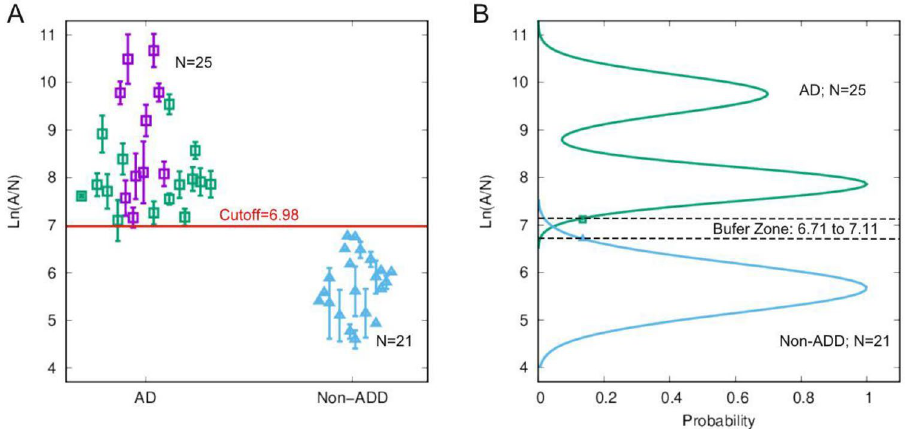
Figure 2. ( A ) Ln(A/N) Morphology Index (MI) values in human fibroblast cultures on Matrigel matrix. The MI index was plotted for cells of patients from two different categories: (i) AD (purple squares), (ii) comorbid AD (AD with other non-AD pathology (mixed diagnosis of AD, Parkinson’s disease, and Lewy body disease, frontotemporal dementia, etc.-green squares), (iii) non-AD dementia (non-ADD, i.e., Parkinson’s disease FTD, LBD—blue triangles), all cell lines from patients confirmed by autopsy. This method accurately diagnosed AD patients distinguishing them from non-ADD patients. ( B ) Probability Gaussian distributions for the AD (green) and non-ADD populations (blue) as a function of Ln(A/N). The dashed black lines represent the buffer zone boundaries determined at the level of four standard deviations for each Gaussian distribution (see methods section). The small peak in the AD distribution is due to high passage (> 10) cell